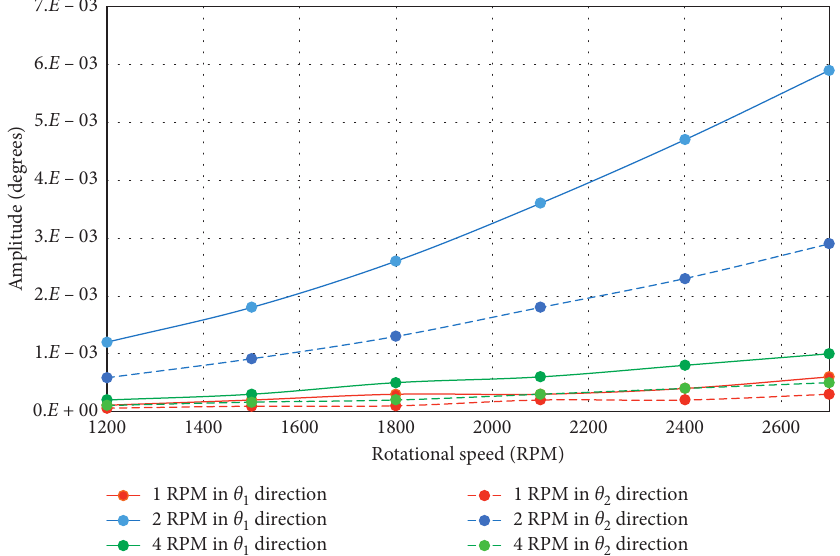
Figure 22: Effects of different rotational speeds on the vibration response of a system with imbalance and angular